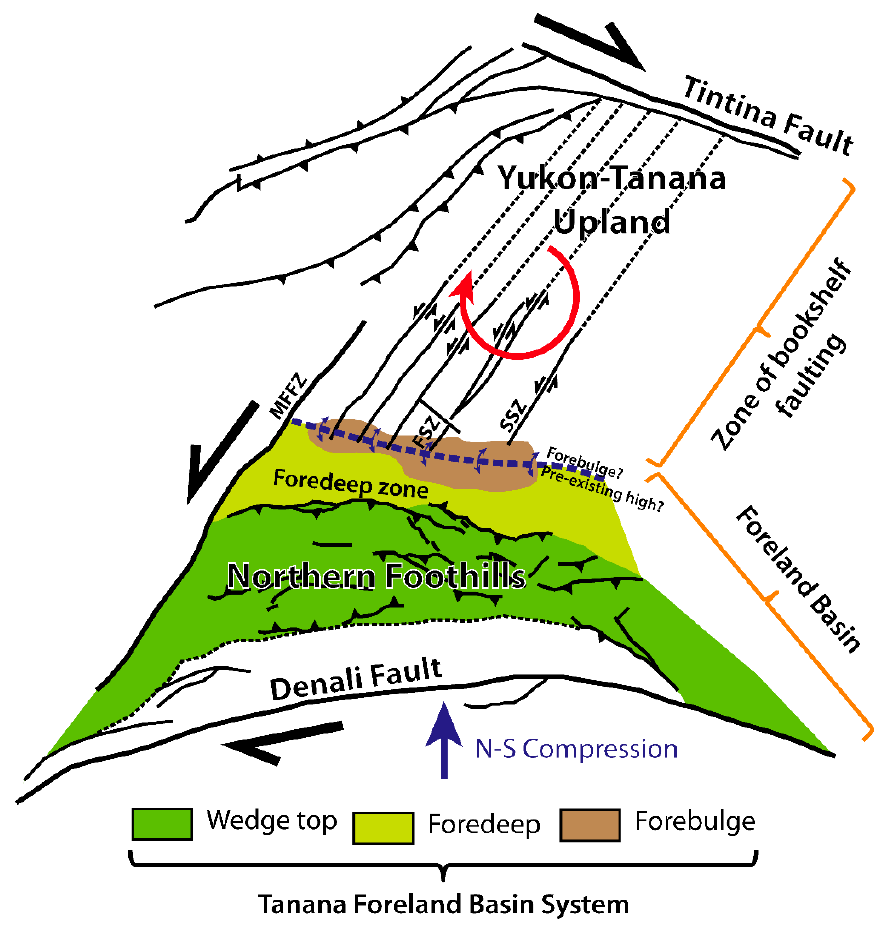
Figure 13. Simplified foreland-flexural deformation model presented for the Tanana basin in which the thrust belt of the Alaska Range drives north–south directed shortening in the basin. North of the thrust belt, progressive flexural subsidence due to crustal loading causes the development of the foredeep along the northern margin of the foothills of the northern Alaska Range. In this model, the Tanana High is the forebulge of the Alaska Range foreland basin or, alternatively, is a basement high underlain by the leading edge of the Alaska Range fold-and-thrust belt. Compression north of the Tanana High drives clockwise rotation of crustal blocks facilitated by left-lateral motion on northeast-striking faults, marked by a zone of bookshelf-style faulting and rotation. zone causes contemporaneous left-lateral strike-slip displacements on the northeast-striking fault systems in the north (Figure 13). The regional convergence results in clockwise rota- tion of fault blocks in the bookshelf faulting zone around a pole of rotation located at the Yukon–Tanana Upland in the north. As crustal shortening in the foreland basin zone is taken up by the bookshelf-style rotation of the crustal blocks, the continental crust in this region stays relatively flat and